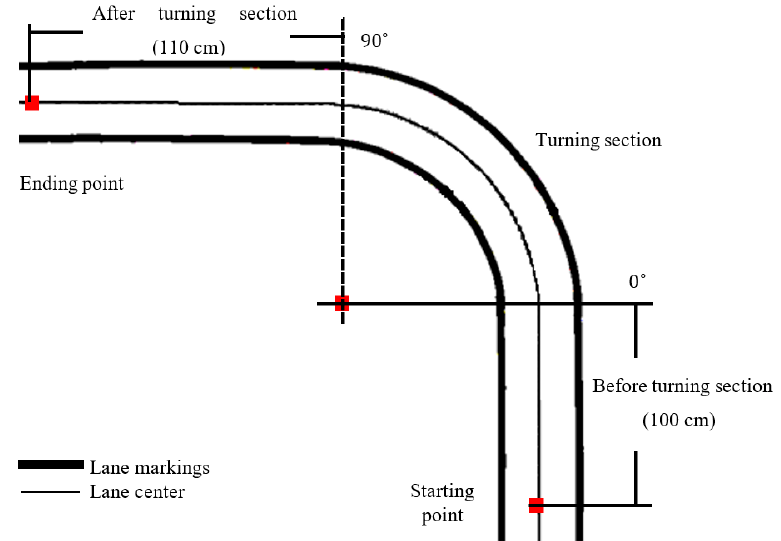
Figure 6. The route with lane center (solid line) and lane markings (thick line) for experimental verification of the image sensor in lane detection and control.